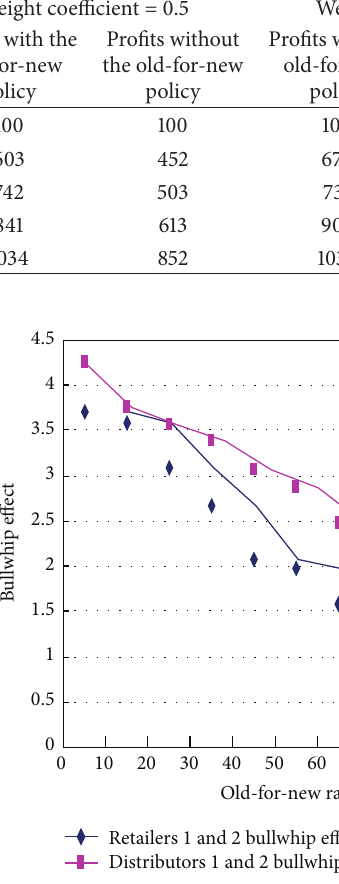
Figure 5: The old-for-new policy has influence on the bullwhip effect.